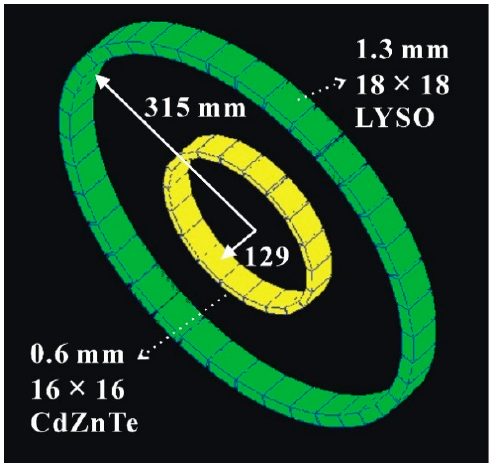
Figure 2. Geant4 application for emission tomography (GATE) simulation geometry of the prototype PET imaging system. The LYSO detectors and CdZnTe detectors were divided into two full rings to acquire coincidence